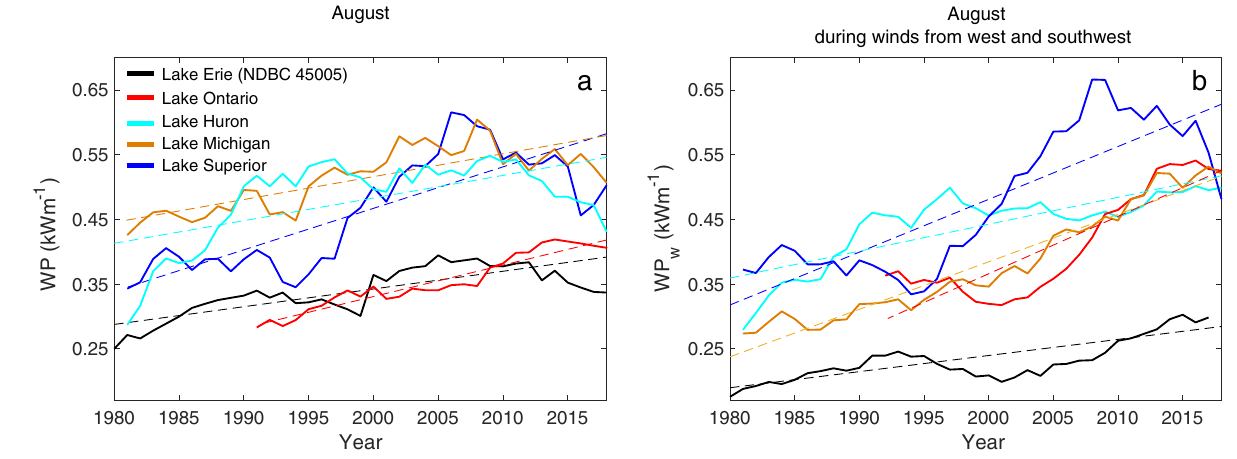
Figure 2. Historical patterns in wave power in Great Lakes. 10 year moving average of wave power ( WP ) during the August ( a ) and during August with the wind from south and southwest and ( WP w ; b ). The dashed lines show the linear regression (statistical results provided in Table